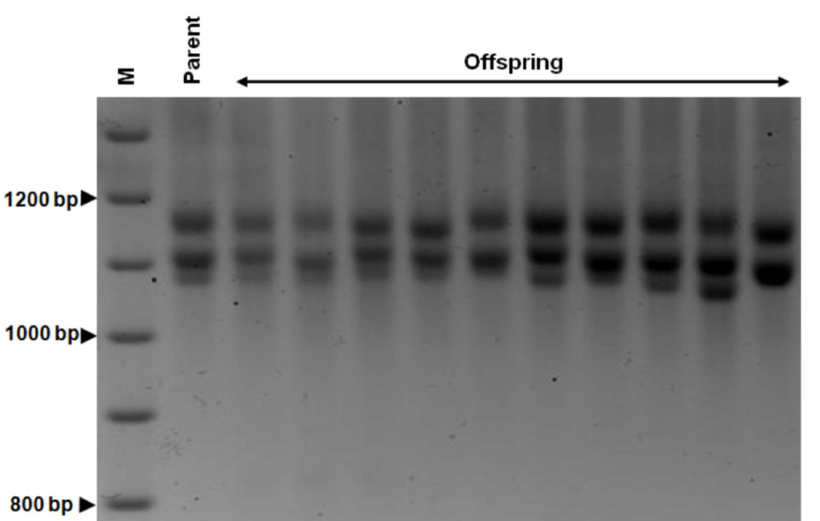
Figure 1. Intergenerational GAA repeats. Representative example of the ethidium bromide-stained agarose gels used to determine the GAA repeat sizes, showing GAA PCR products obtained from a YG22 GAA + / Mlh1 + / + parent and 10 GAA + offspring. M=100 bp DNA size marker.